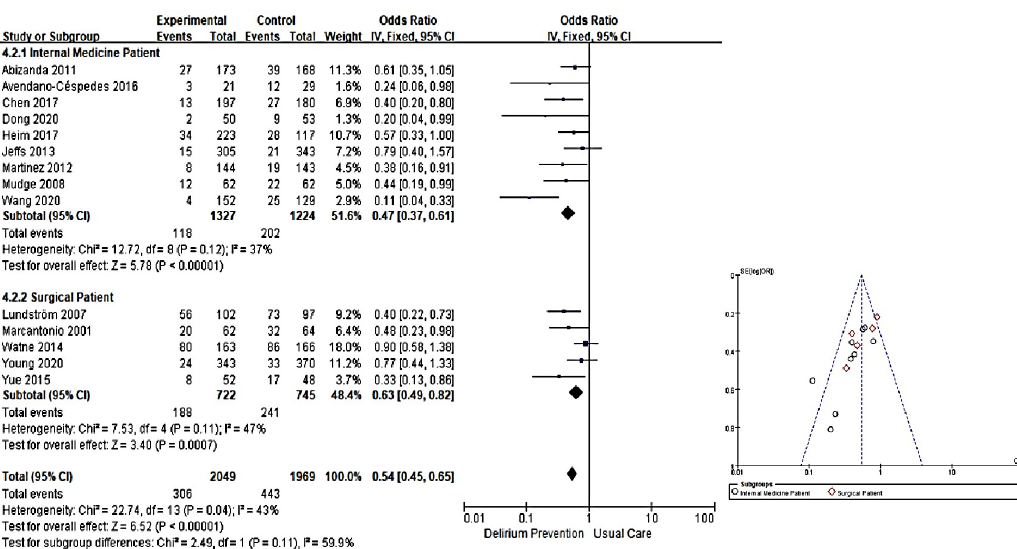
Fig 4. Forest plot of effect of incidence of delirium by subgroup and funnel